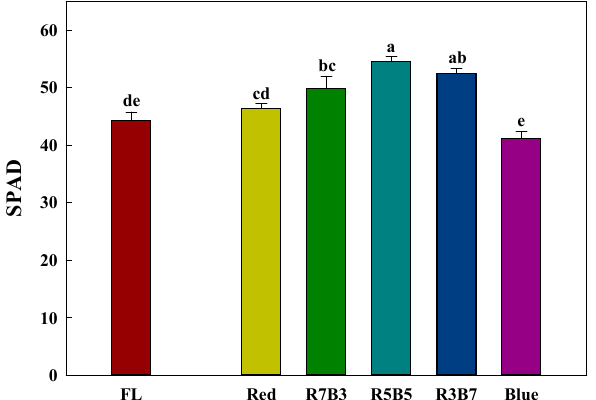
Figure 4. SPAD (soil-plant analysis development) values of Salvia plebeia R. Br. as affected by different light treatments at 35 days after transplanting. Vertical bars represent the standard deviation from the mean ( n = 3). Different letters in the same column indicate significant differences based on Tukey’s multiple range test ( α ≤ 0.05).